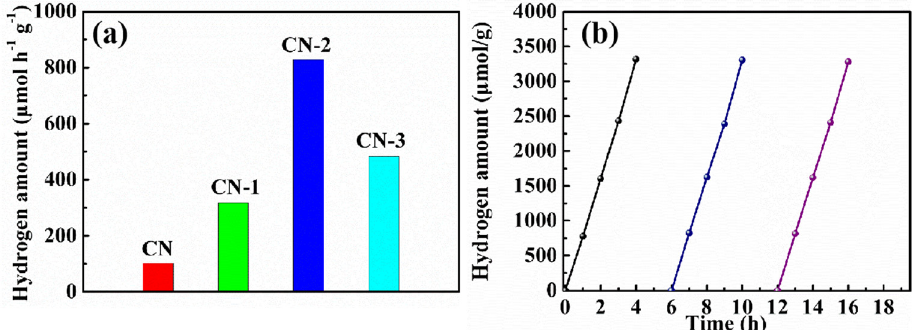
Figure 6. ( a ) Photocatalytic hydrogen evolution of CN, CN-1, CN-2, and CN-3 samples, ( b ) Stability test of hydrogen evolution for CN-2 under visible light irradiation.